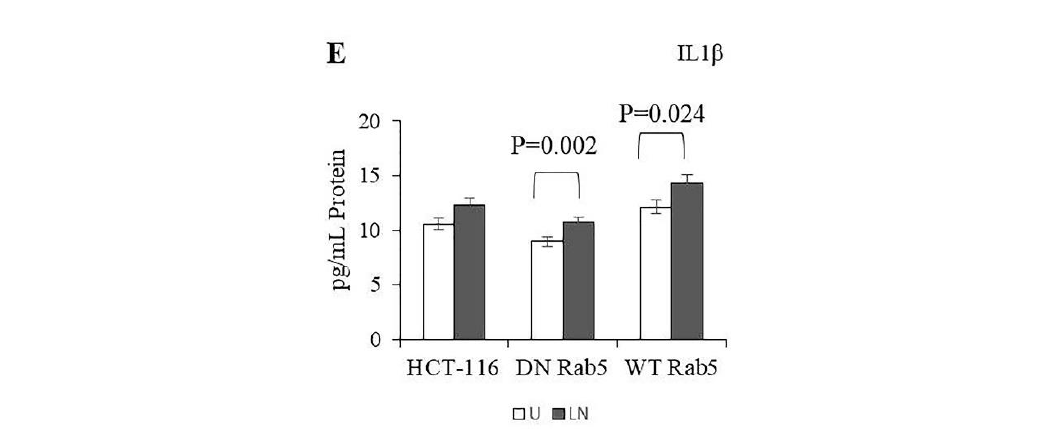
Figure 2. The e ff ects of Rab5 on the NALP3 inflammasome. To assess NALP3 activation, HCT116 cells transfected with pDsRed-Rab5 WT and pDsRed-Rab5 DN were primed with LPS (1 µ g / mL) for 3 hours and then treated with nigericin (20 µ M) for 24 hours. ( A – D ) The e ff ects of DN Rab5 and WT Rab5 on the expression of NLRP3 , RAB39A , Pro-CASP1 and Pro-IL1 β in the untreated and LPS / nigericin-treated HCT116 cells. ( E ) The DN Rab5 and WT Rab5 e ff ect on IL1 β secretion in the untreated and LPS / nigericin-treated HCT116 cells. U: untreated; LN: LPS / nigericin treated ( n = 3 for each experiment; p -values were calculated using independent sample T test).